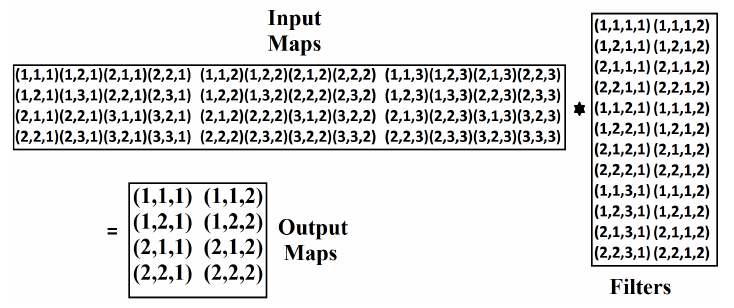
Figure 3. Convolution matrix